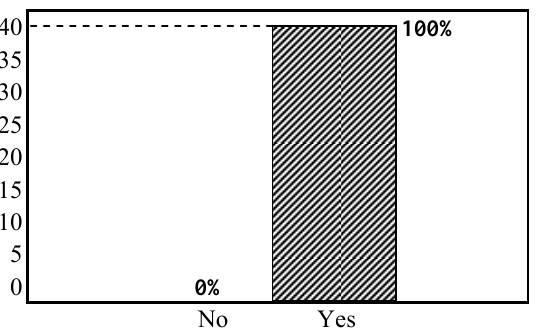
Figure 3: Appliances; electronics; flowers and gifts; house and garden; jewellery; lingerie; music; sports and recreation; toys and hobbies;